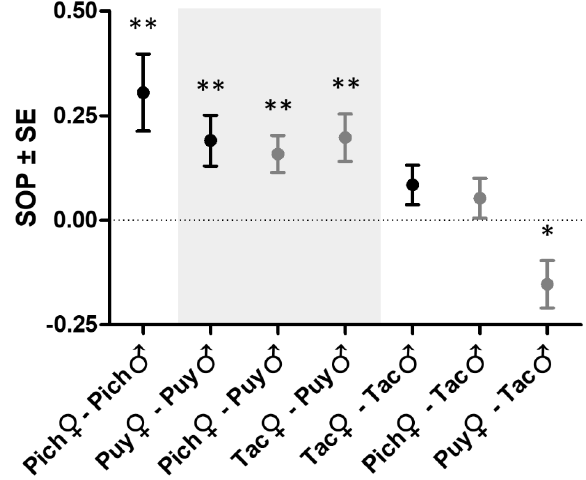
Figure 3. Mean ± SE strength of preference for own over H 2 S-adapted males in Poecilia spp. females from non-sulfidic habitats. The tests were conducted within drainages (black symbols; data from Plath et al. [12]) and with stimulus males from another drainage (gray symbols; tests novel to this study). The different backgroud shading groups the tests by the drainage from which the stimulus males were taken. The asterisks indicate significant deviation from the null hypothesis of SOP = 0 (two-sided one-sample t -tests; * p < 0.05, ** p <